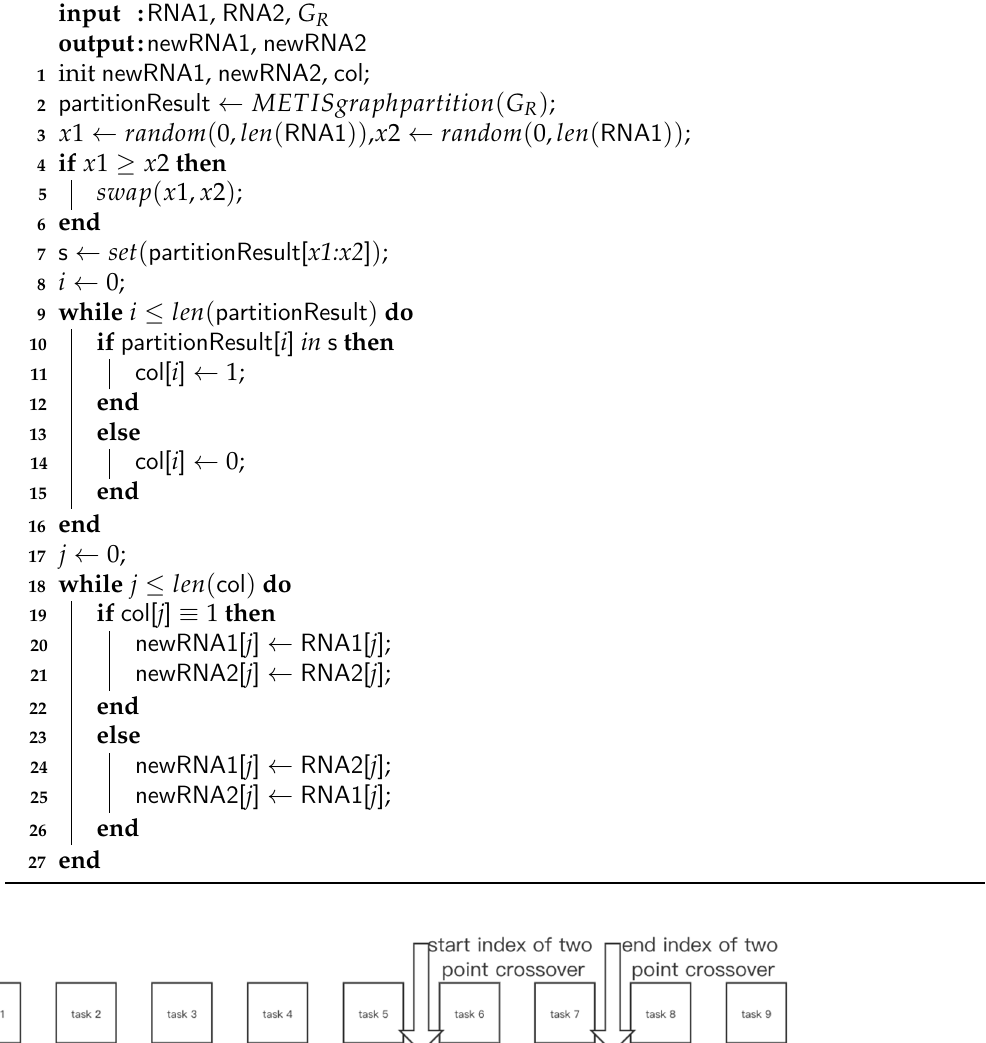
Algorithm 2: HeuristicDoublePointRecombination